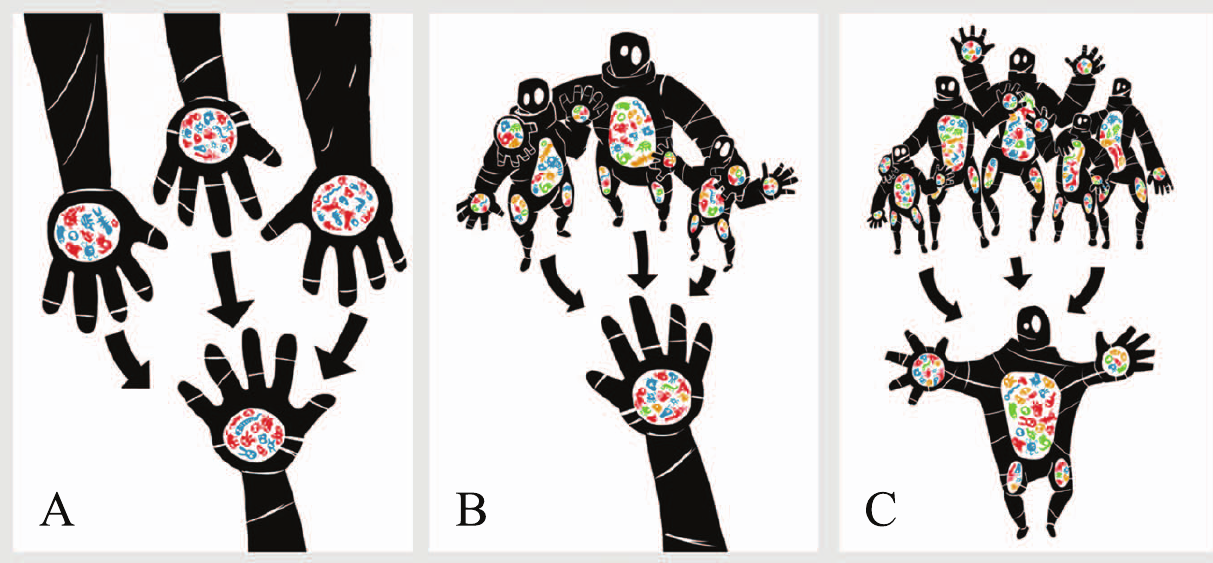
thought of as a sample from all microbiota across multiple humans. Finally, the local community in (C) is all microbiota from a single human subject, while the metacommunity is again microbiota from multiple habitats across multiple humans.